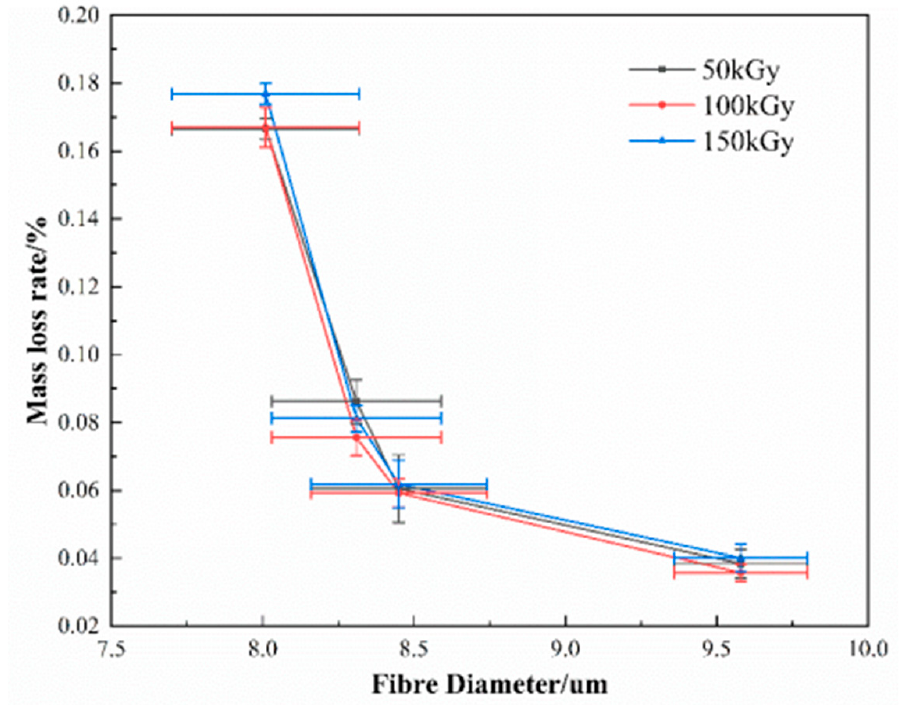
Figure 11. Variation of mass loss rate with fiber diameter.